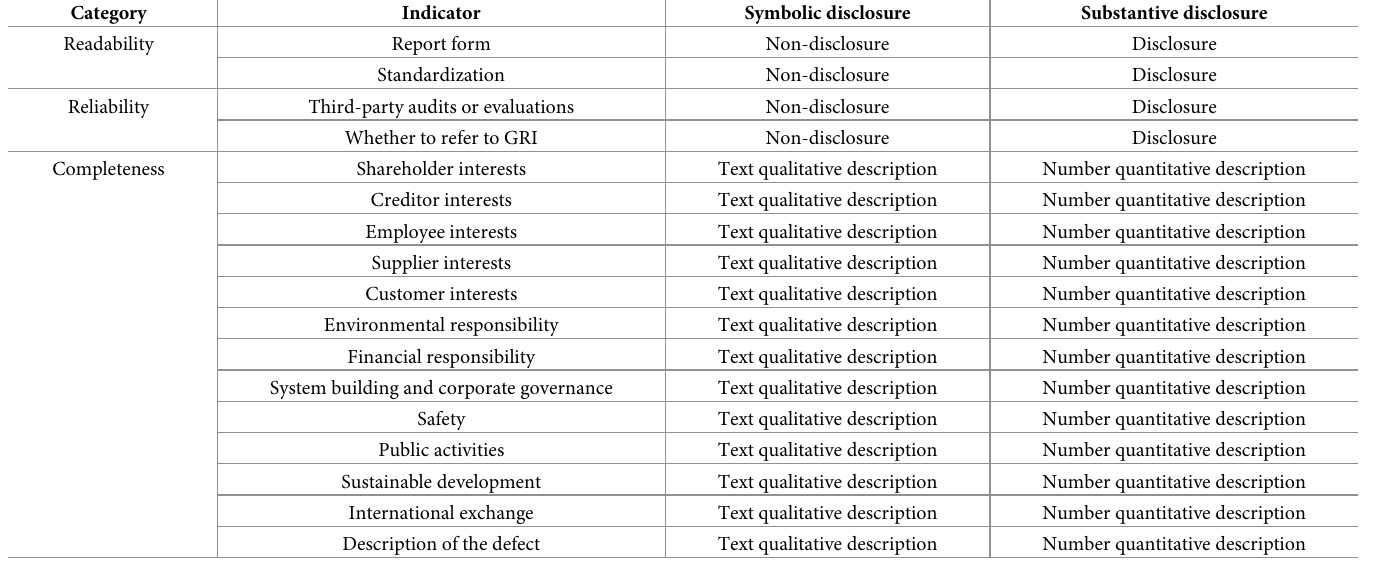
Table 2. Sustainability reporting “greenwashing” indicator